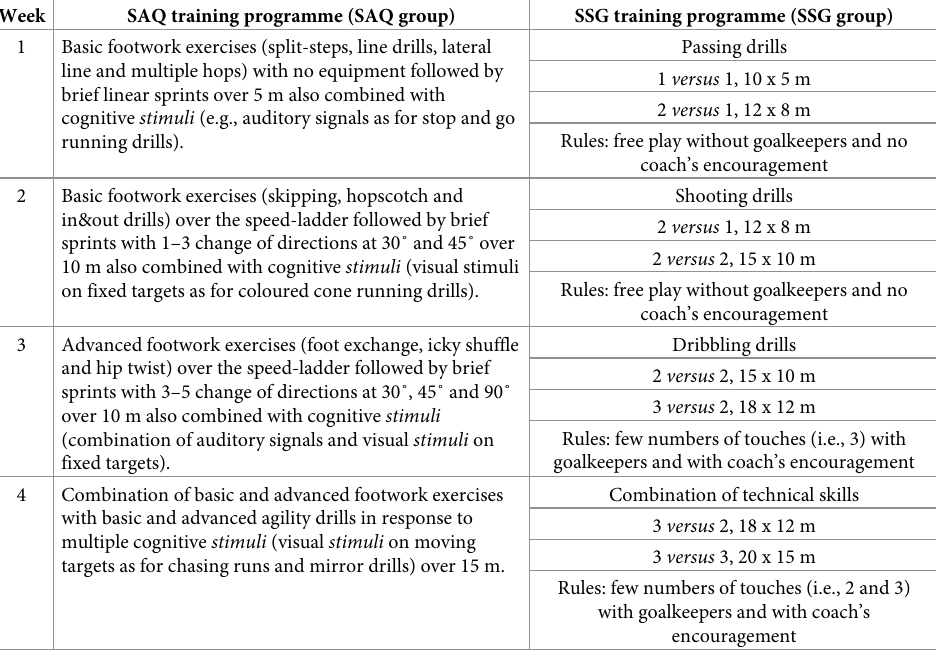
Table 1. Training content of the 4-week intervention performed by the SAQ group and by the SSG group. Week Basic footwork exercises (split-steps, line drills, lateral line and multiple hops) with no equipment followed by brief linear sprints over 5 m also combined with cognitive stimuli (e.g., auditory signals as for stop and go running drills). Basic footwork exercises (skipping, hopscotch and in&out drills) over the speed-ladder followed by brief sprints with 1–3 change of directions at 30˚ and 45˚ over 10 m also combined with cognitive stimuli (visual stimuli on fixed targets as for coloured cone running drills). Rules: free play without goalkeepers and no Advanced footwork exercises (foot exchange, icky shuffle and hip twist) over the speed-ladder followed by brief sprints with 3–5 change of directions at 30˚, 45˚ and 90˚ over 10 m also combined with cognitive stimuli (combination of auditory signals and visual stimuli on fixed targets). Combination of basic and advanced footwork exercises with basic and advanced agility drills in response to multiple cognitive stimuli (visual stimuli on moving targets as for chasing runs and mirror drills) over 15 m.